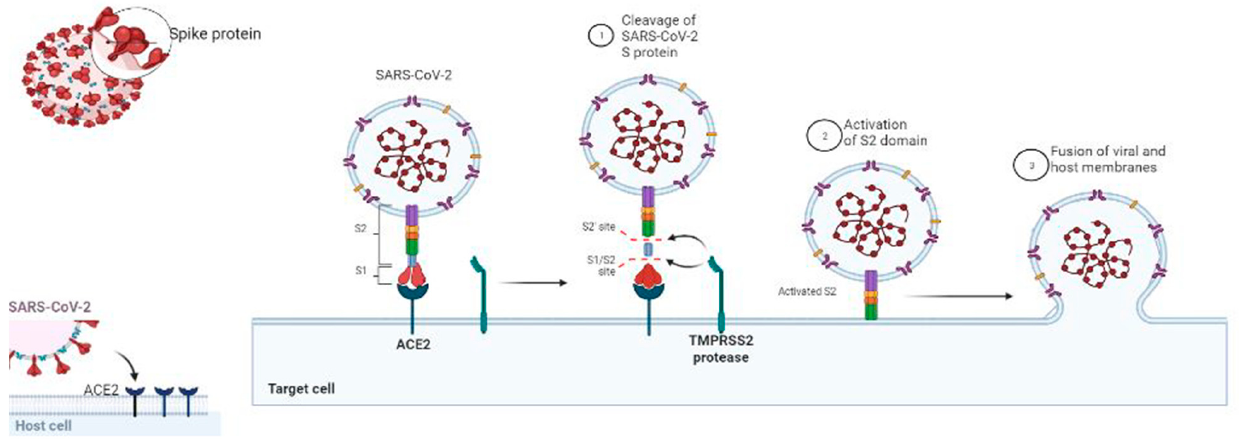
Figure 2. Pathogenesis of COVID-19 virus.